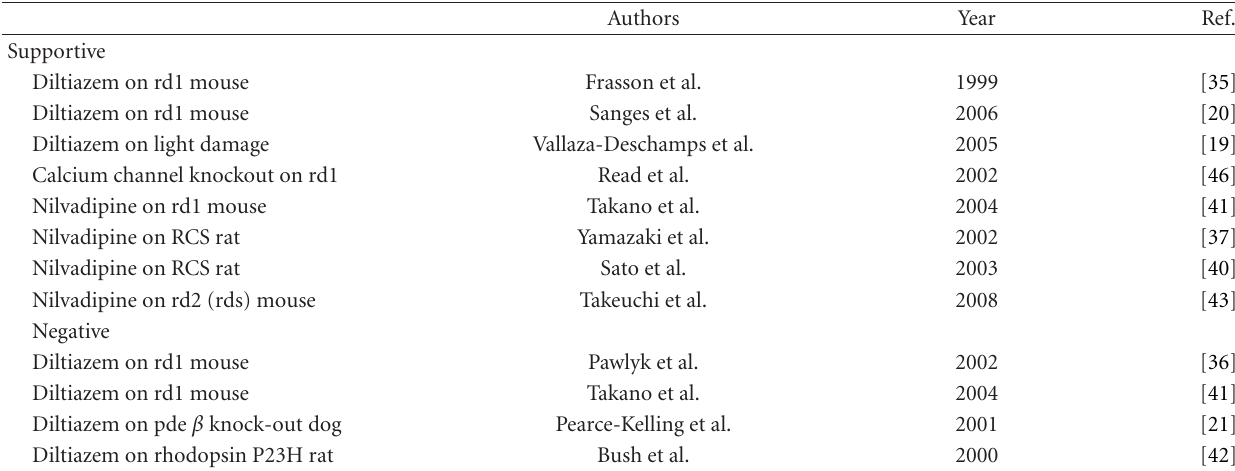
Table 2: Photoreceptor rescue by calcium channel